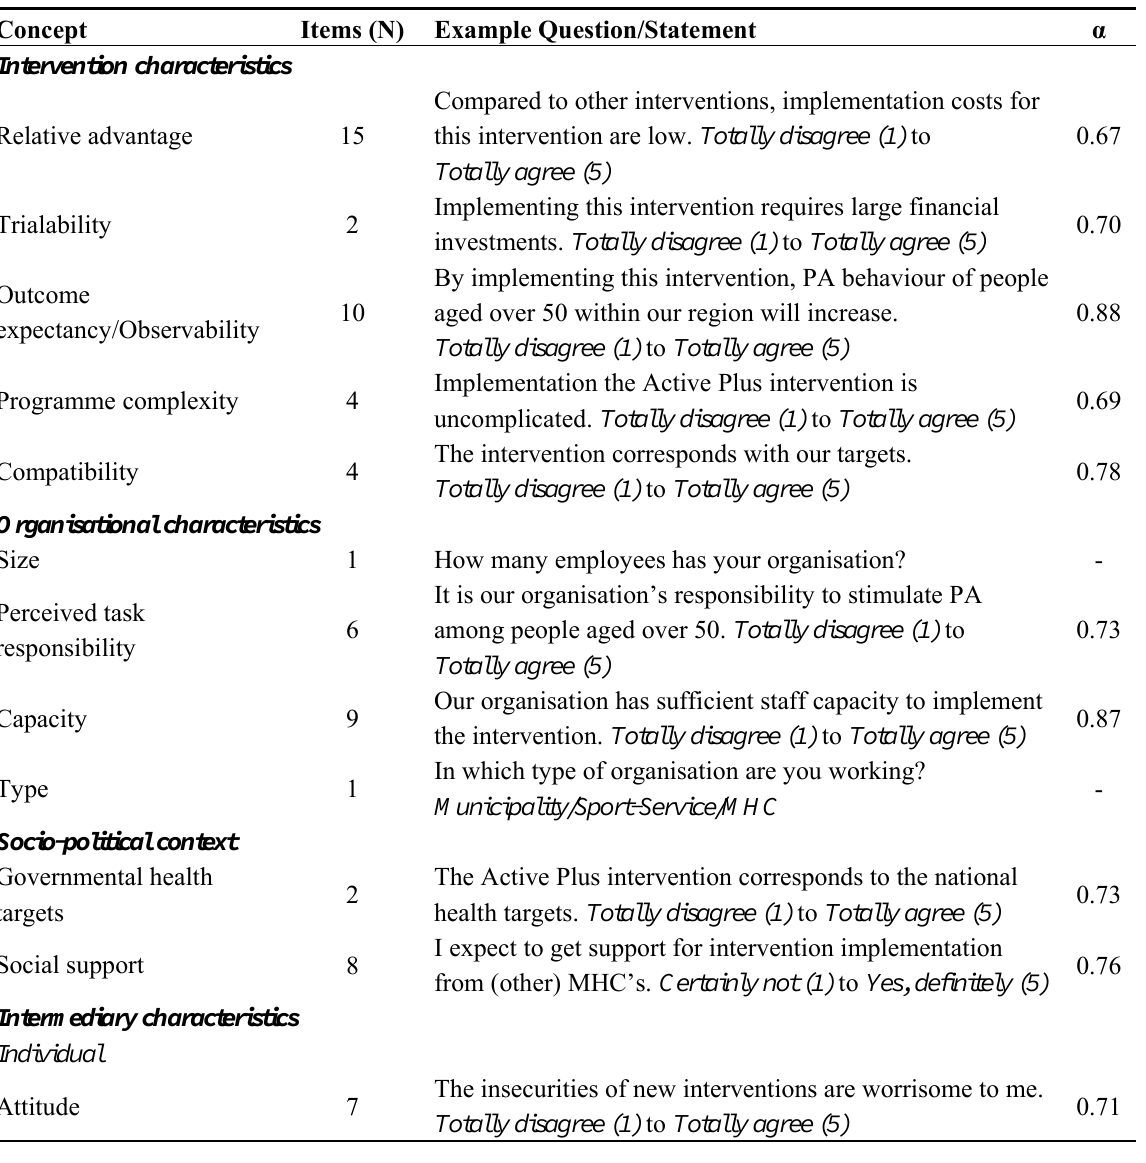
Table 1. Measurements of characteristics of the intervention, organisation, socio-political context, intermediary, and their